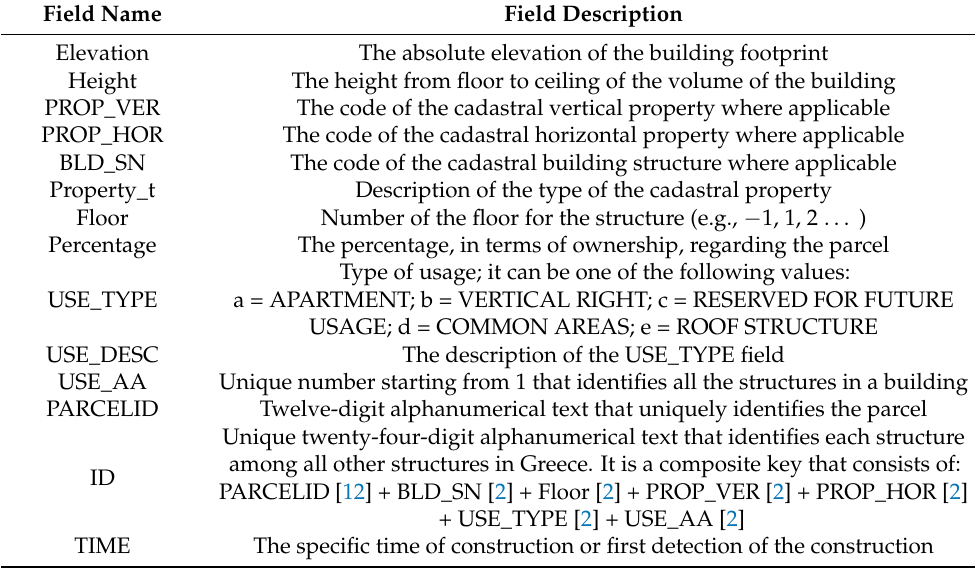
Table 2. Proposed metadata schema in the internal database of the